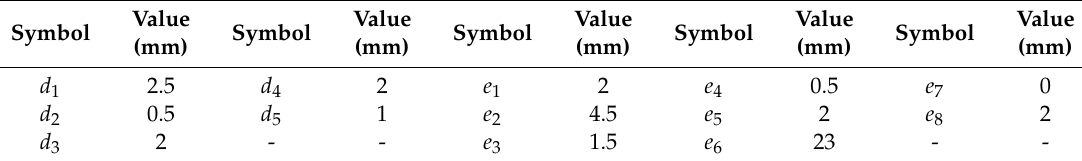
Figure 6. 2-D axisymmetric models of electromagnetic actuators. ( a ) Solenoid actuator (SA); ( b ) moving coil actuator (MCA); and ( c ) moving magnet actuator (MMA). 1. Plunger; 2. iron core; 3. axis of symmetry; 4. magnet; 5. iron-ring; 6. fixed support; 7. insulated aluminum ring; 8. shell; and 9. coil. Table 2. Basic geometric dimensions of models prior to modification.